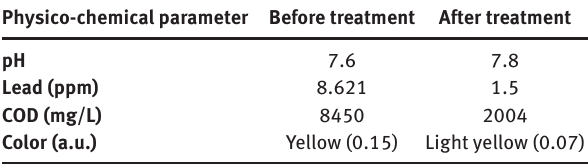
Table 2: Water characteristics before and after treatment. Physico-chemical parameter Before treatment After